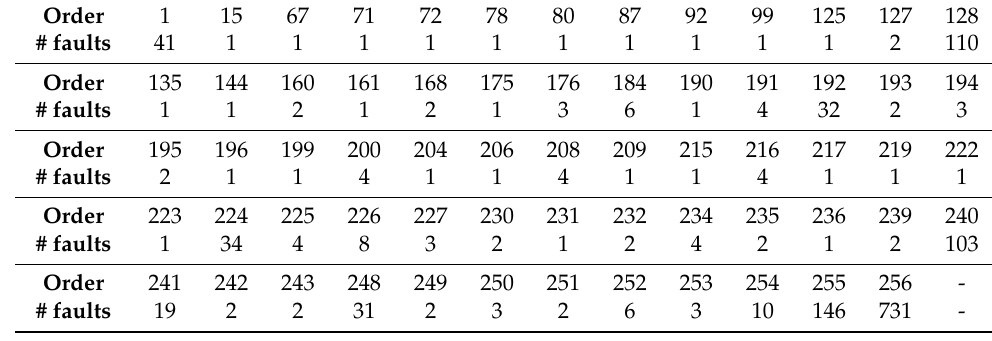
Table 2. Statistics on fault orders.